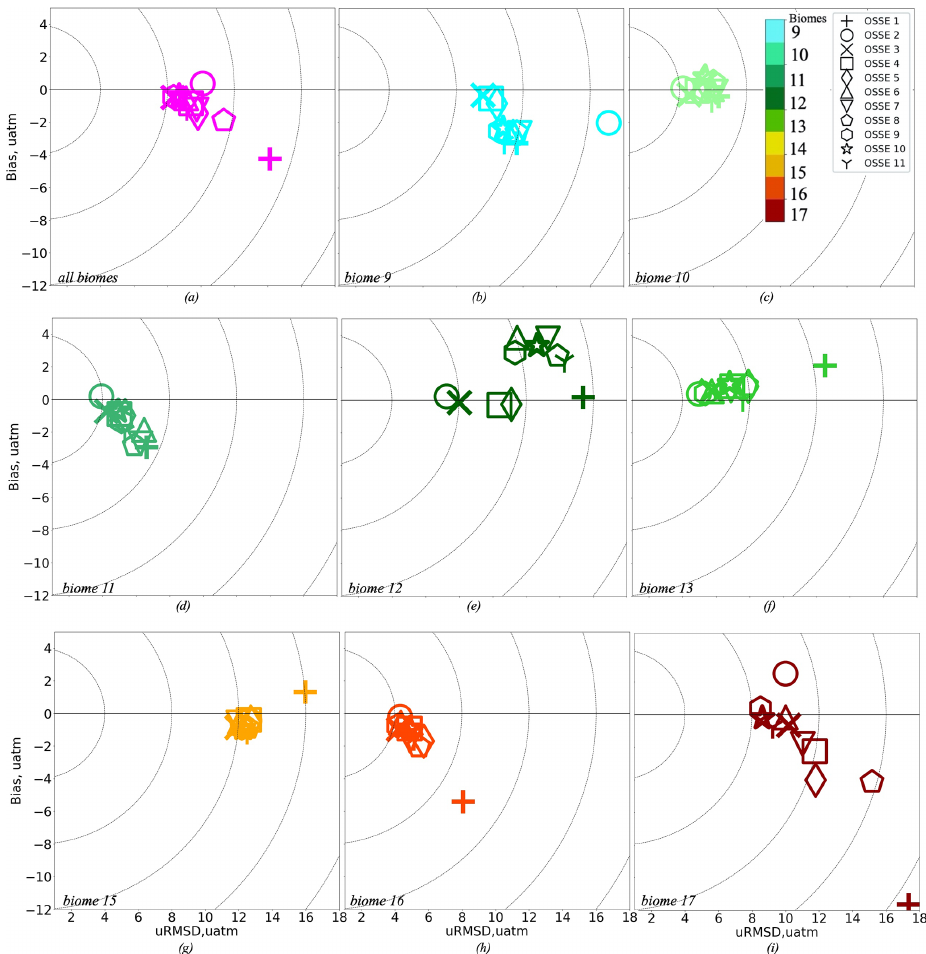
Figure 4. Target diagram per biome for 11 OSSEs, the colour code corresponds to Fig. 2, and the purple colour represents all of the eight biomes combined: (a) all eight biomes, (b) biome 9 (subpolar seasonally stratified North Atlantic), (c) biome 10 (subtropical seasonally stratified North Atlantic), (d) biome 11 (subtropical permanently stratified North Atlantic), (e) biome 12 (equatorial Atlantic), (f) biome 13 (subtropical permanently stratified South Atlantic), (g) biome 15 (subtropical seasonally stratified Southern Ocean), (h) biome 16 (subpolar seasonally stratified Southern Ocean), (i) biome 17 (Southern Ocean ice). OSSE 1 uses SOCAT data only; OSSE 2 uses synthetic Argo data only; OSSE 3 uses SOCAT and synthetic Argo data; OSSE 4 is SOCAT data and 25% of the original synthetic Argo data; OSSE 5 uses SOCAT data and 10% of the original synthetic Argo data; OSSE 6 uses SOCAT data and synthetic Argo data in the Southern Hemisphere; OSSE 7 uses SOCAT data and 25% of the original synthetic Argo data in the Southern Hemisphere; OSSE 8 uses SOCAT data and 10% of the original synthetic Argo data in the Southern Hemisphere; OSSE 9 uses SOCAT data, synthetic Argo data in the Southern Hemisphere, and data from mooring stations; OSSE 10 uses SOCAT data, 25% of the original synthetic Argo data in the Southern Hemisphere, and data from mooring stations; and OSSE 11 uses SOCAT data, 10% of the original synthetic Argo data in the Southern Hemisphere, and data from mooring stations. OSSEs 1, 3 and 10 are in bold as we focus our detailed comparison on these three OSSEs.